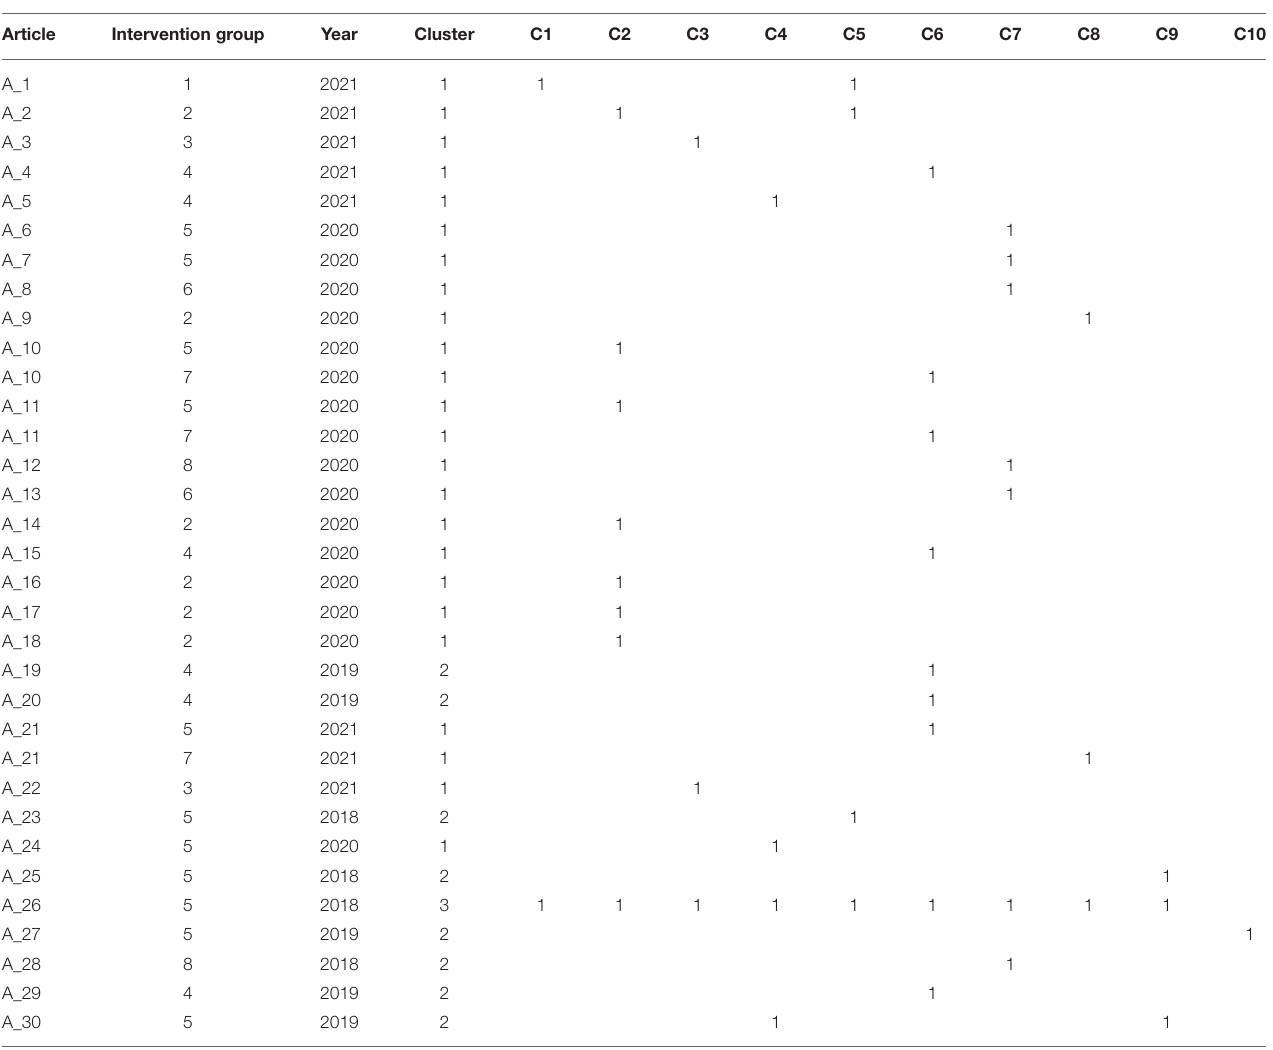
TABLE 2 | Classification of